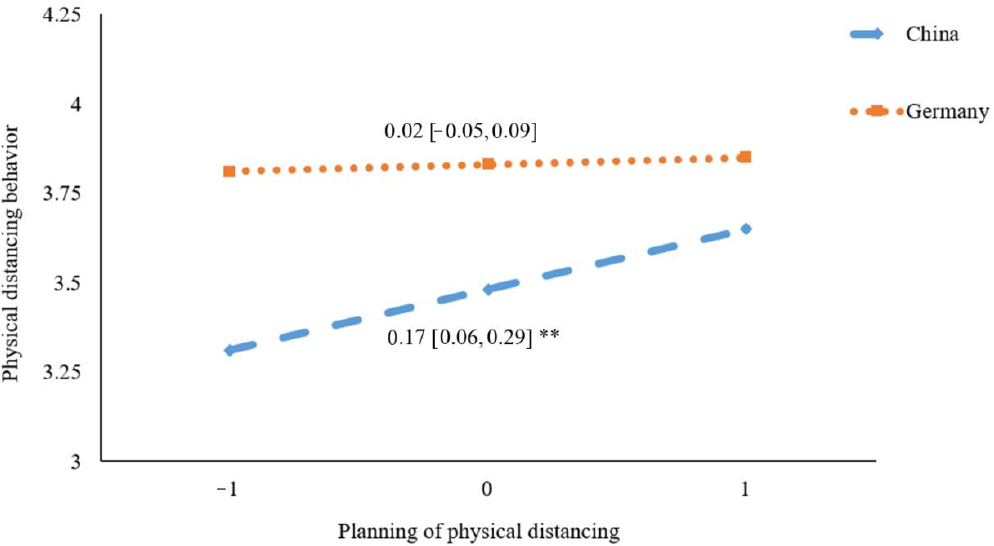
Figure 5. Plot of simple slopes showing the association between planning and social distancing at different countries ( n = 578); ** p < 0.01.